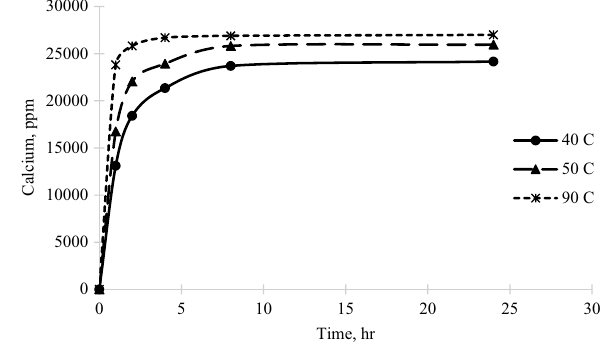
Fig. 4 Dissolution study of mixed scale Sample 2 with MAPE–HCl– DLABSA–GE